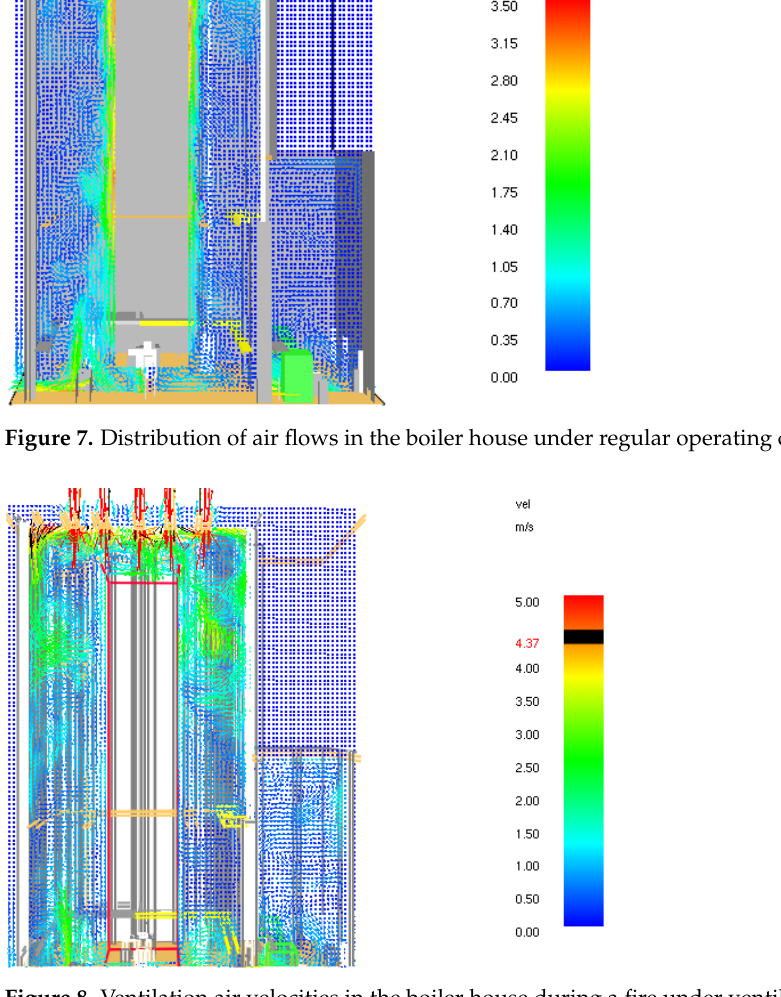
Figure 8. Ventilation air velocities in the boiler house during a fire under ventilation conditions.